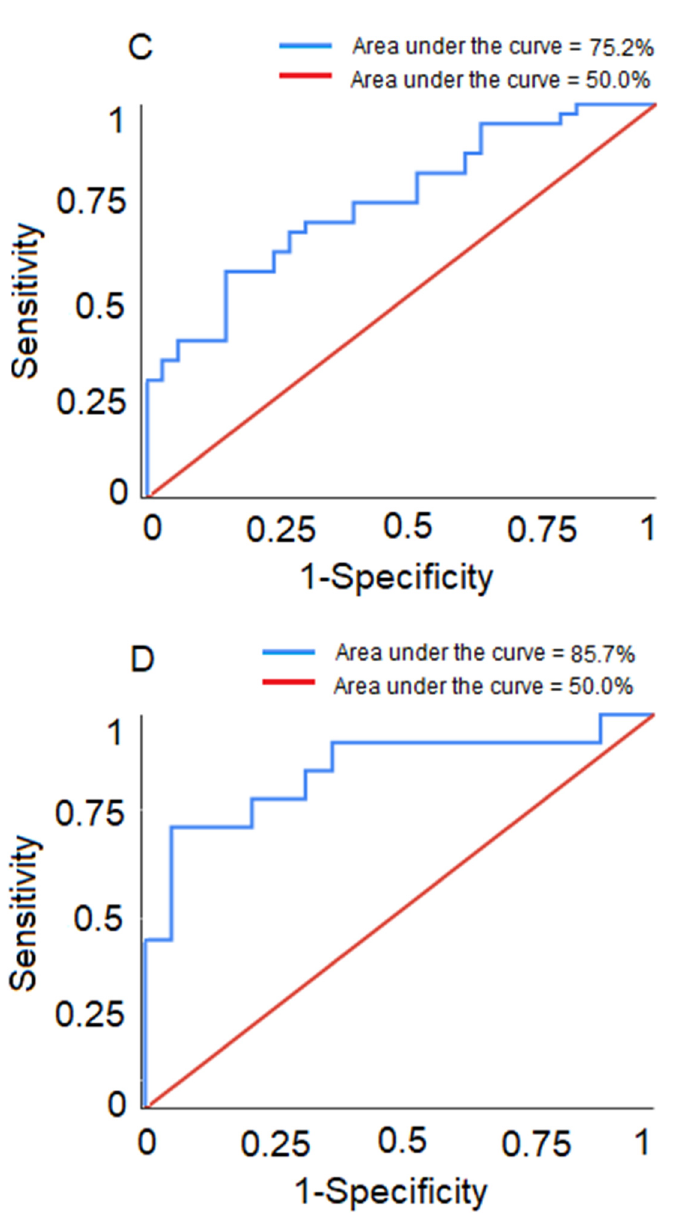
Figure 2. Receiver operating characteristic (ROC) curves for the logistic regression models shown separately for ( A ) the training dataset for multiparous cows, ( B ) the test dataset for multiparous cows, ( C ) the training dataset for primiparous cows, and ( D ) the test dataset for primiparous